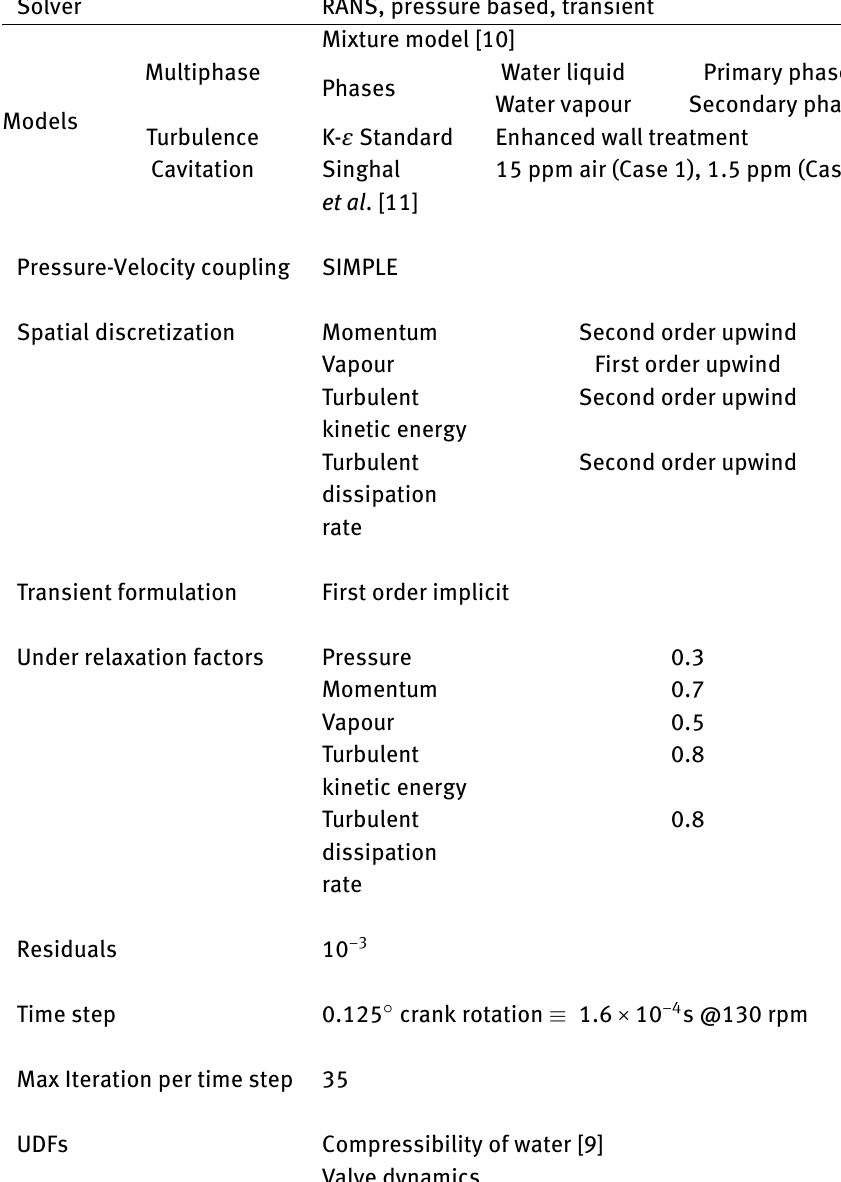
Table 3: Solver settings summary